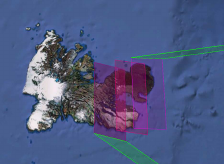
Figure 3. Illustration of Pleiades’ adjacent acquisitions of Kergelen Island with GoogleEarth